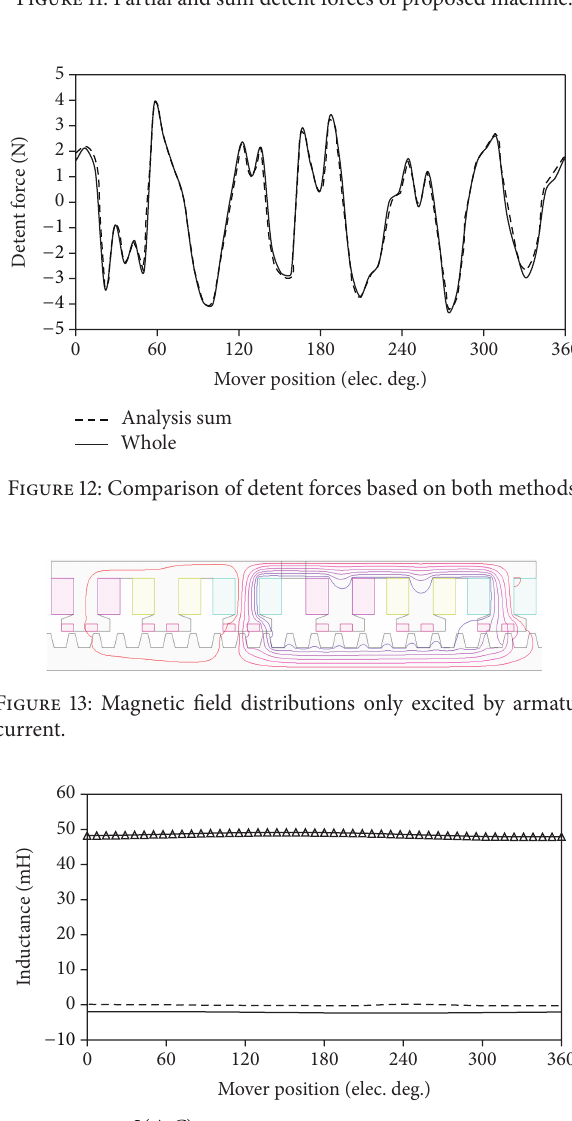
Figure 9: Harmonics analysis of winding and phase back-EMFs.